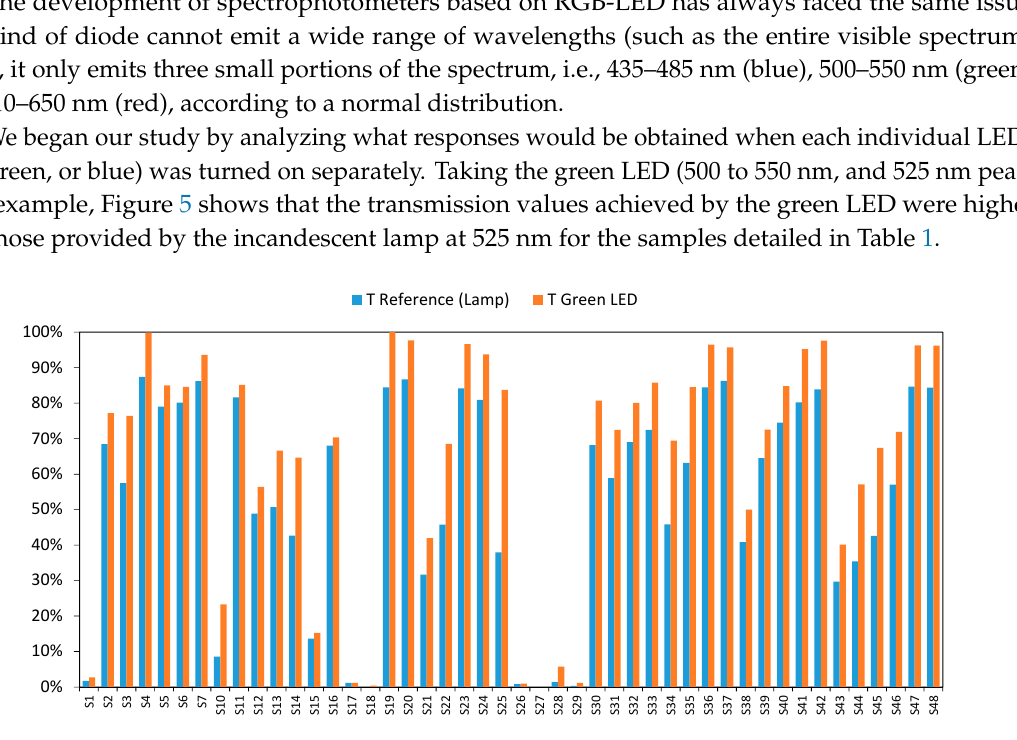
Figure 5. Comparative transmittance value by the green LED and incandescent lamp at 525 nm.